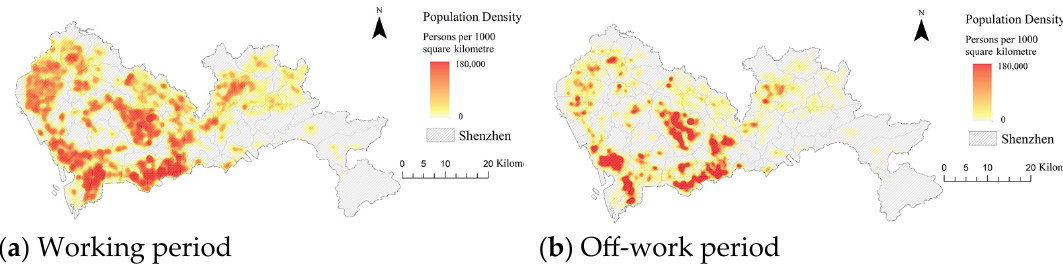
Figure 2. Population density during working and o ff -work periods.